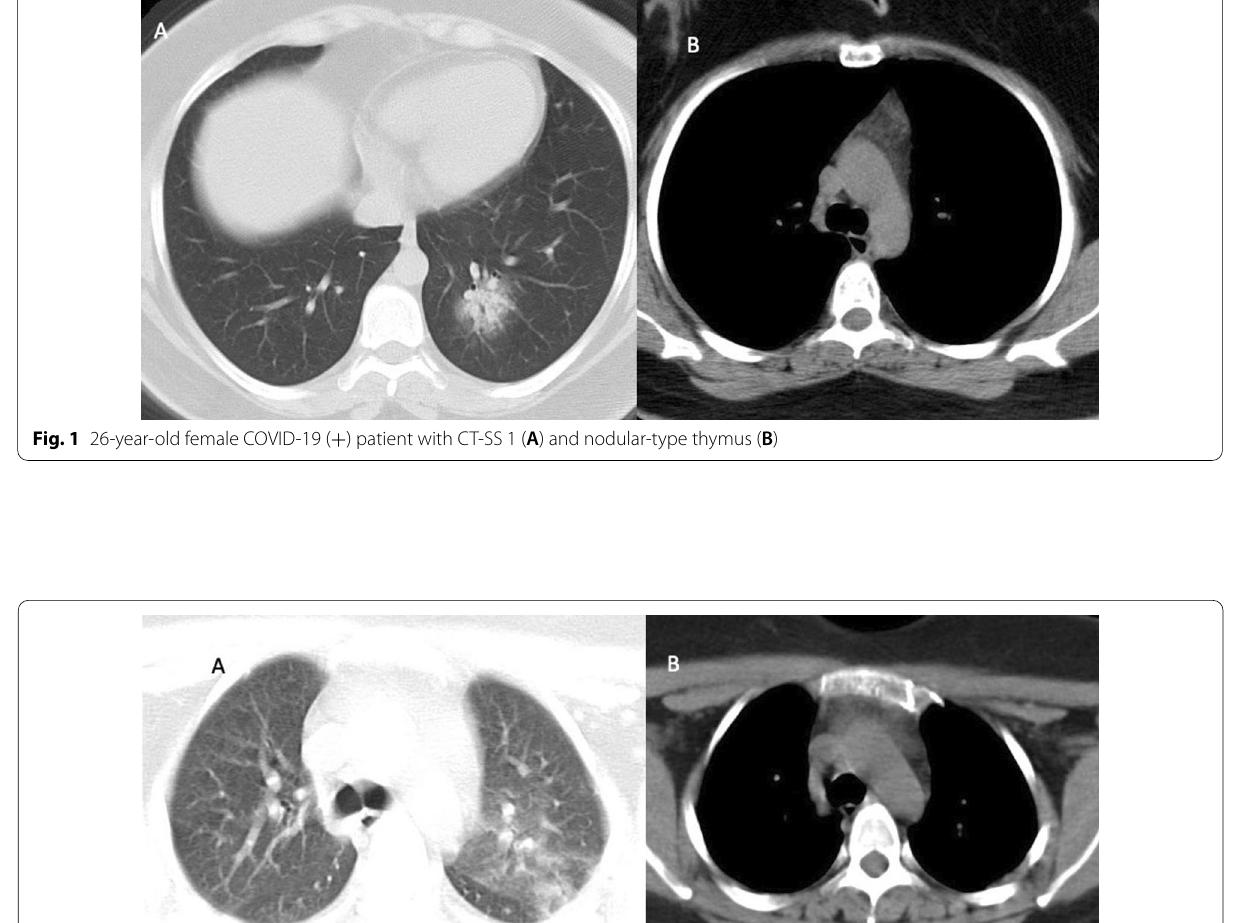
) patient with CT-SS 12 ( A ) and nodular-type thymus ( B ) +